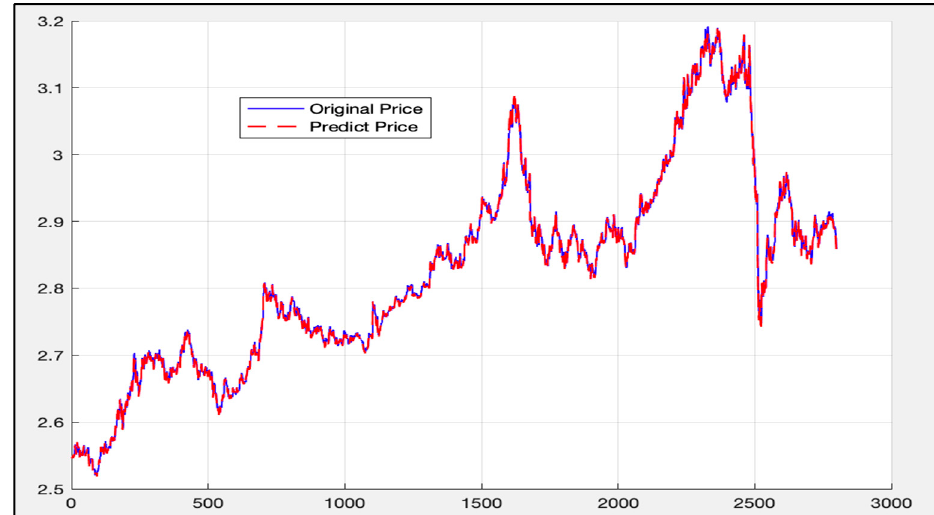
Figure 25. Comparison of LSTM-SVR II prediction results with actual results (8500th data to 11,300th data).